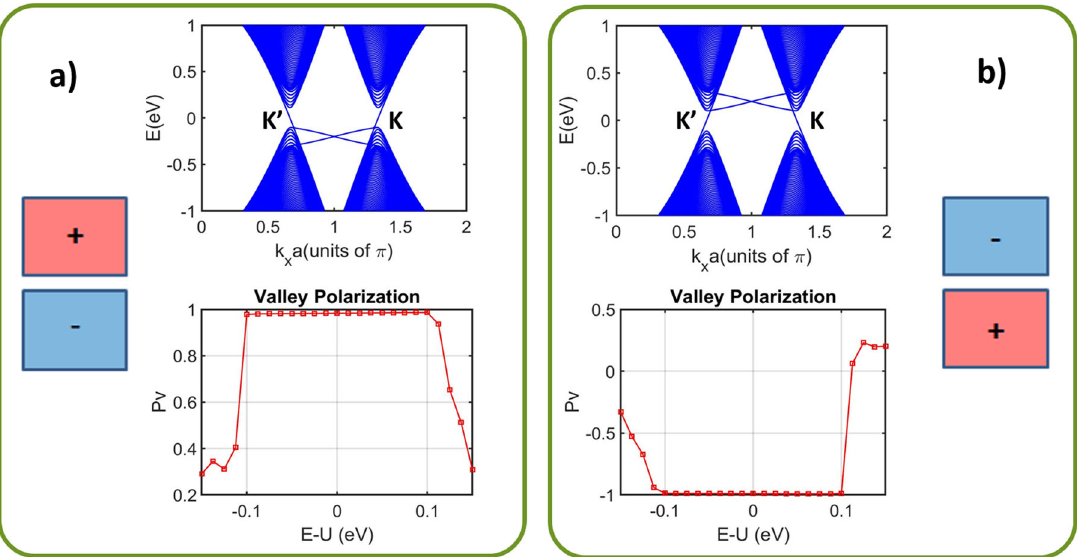
Fig. 3 Gate voltage con fi guration, corresponding band structure and valley polarization of our proposed valley fi lter. a “ ± ” con fi guration gives a K -valley-polarized fi lter for transmission from the left ( L ) to the right ( R ) lead, given the channel electrochemical potential lies within the band gap, because of the right-going electrons being locked to the K -valley. b “ ∓ ” con fi guration gives a K 0 -valley-polarized fi lter as the right- going electrons of the interface states are locked to the K 0